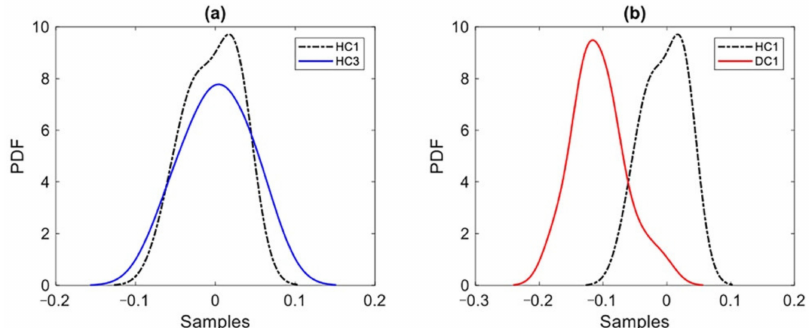
Figure 7. Comparison of the estimated probability distributions of the residual samples relevant to Sensor 4 and to the second deployment scenario: ( a ) states HC1 and HC3; ( b ) states HC1 and